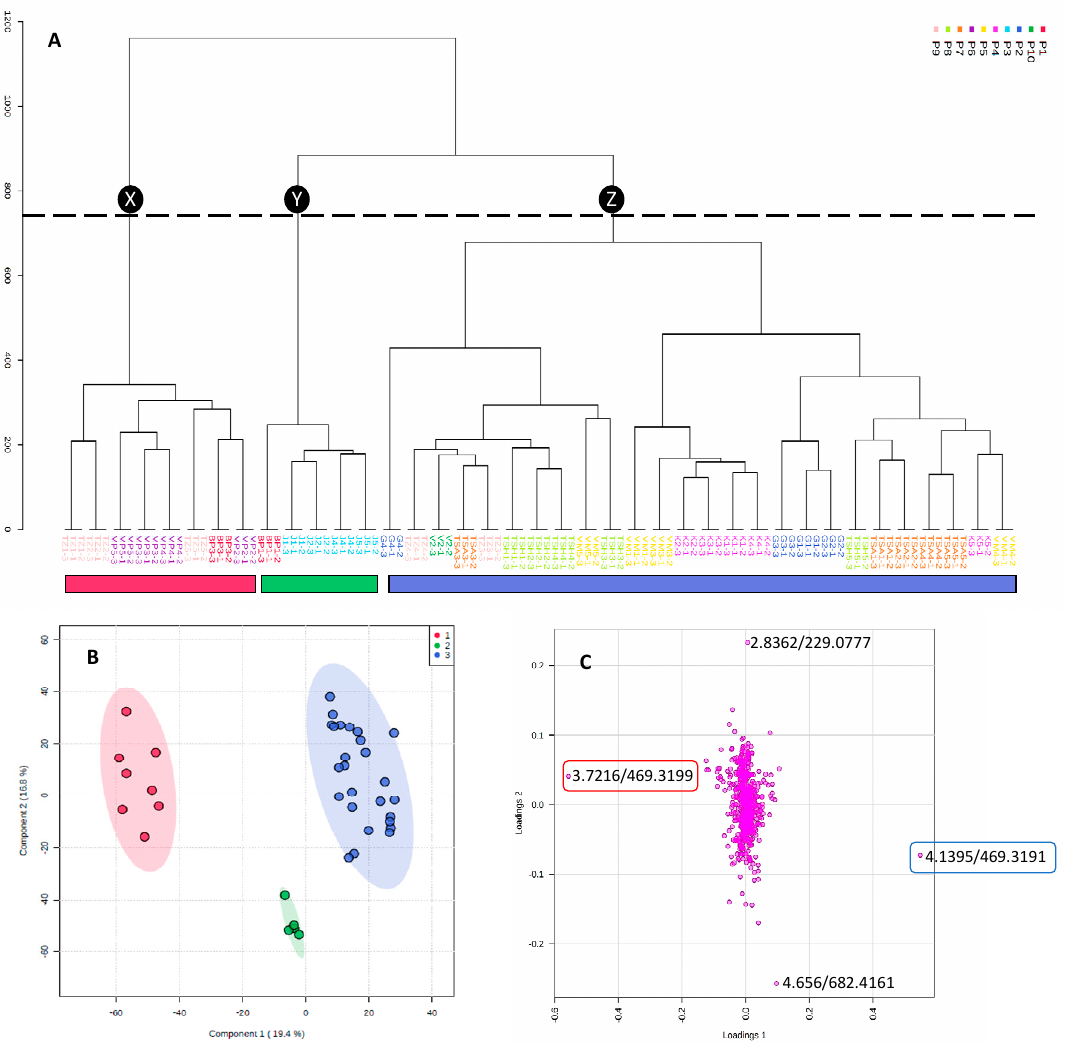
Figure 1. ( A ) Hierarchical cluster analysis dendrogram of the ultra performance liquid chromatography (UPLC)-mass spectrometry (MS) data (N = 39) obtained from Waterberg, Mopani and Vhembe districts of Limpopo Province. Branch X (red): samples from Waterberg and Mopani; branch Y (green): samples from Waterberg and Vhembe; branch Z (blue): samples from Mopani and Vhembe districts. ( B ) Partial least square discriminant analysis (PLS-DA) of clusters from the dendrogram. ( C ) Loadings scores plot obtained from the PLS-DA analysis. Compound indicated by red rectangle contributed to the clustering of the Red (X) group, while compound in blue rectangle contributed to the clustering of the Blue group (Z). These two compounds are the first two variables indicated by the variable importance for project (VIP) plot.